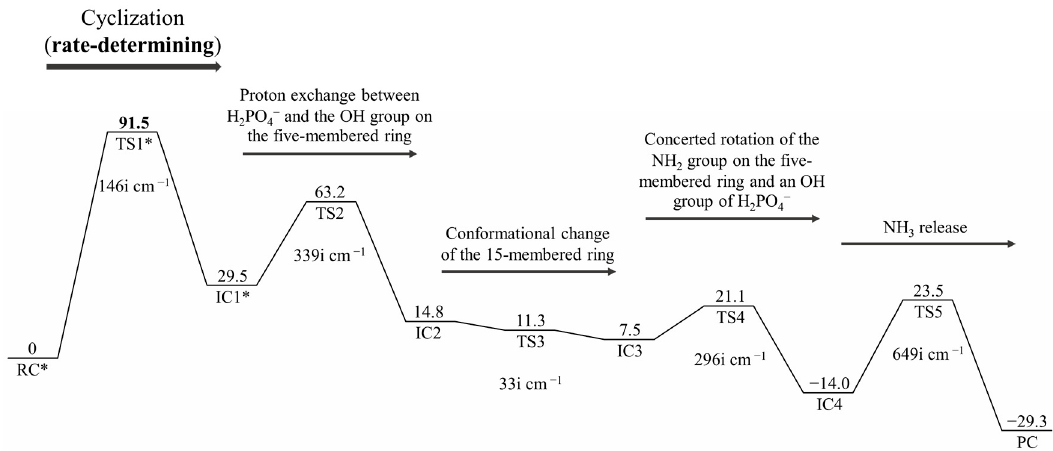
Figure 3. Energy diagram in water at 298.15 K. RC: reactant complex; TS: transition state; IC: intermediate complex; PC: product complex. The geometries labeled by an asterisk (*) (RC*, TS1*, and IC1*) are those previously reported [67]. The relative energies after the thermal and hydration Gibbs energy corrections are shown in kJ mol − 1 with respect to RC*. Also shown are the imaginary frequencies of the five transition states.